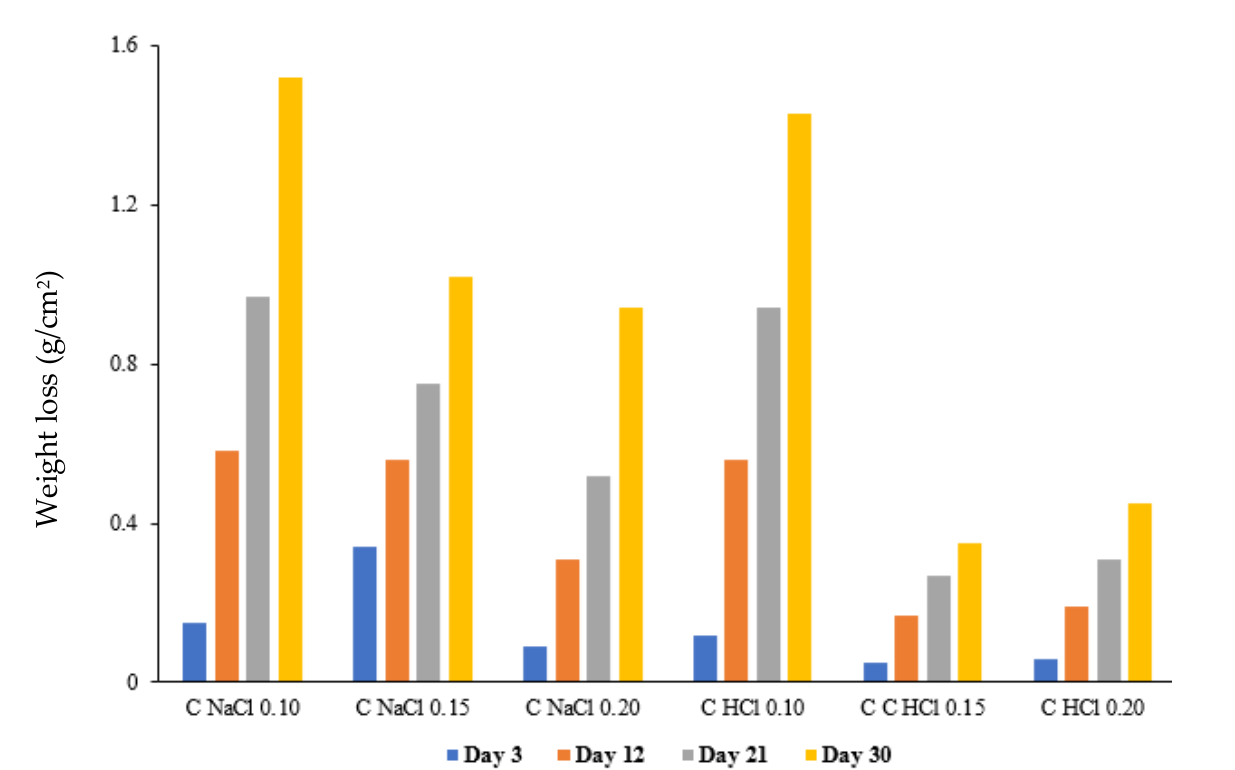
Figure 13. Comparison of the corrosion behaviour of unheated specimen C in HCl and NaCl.